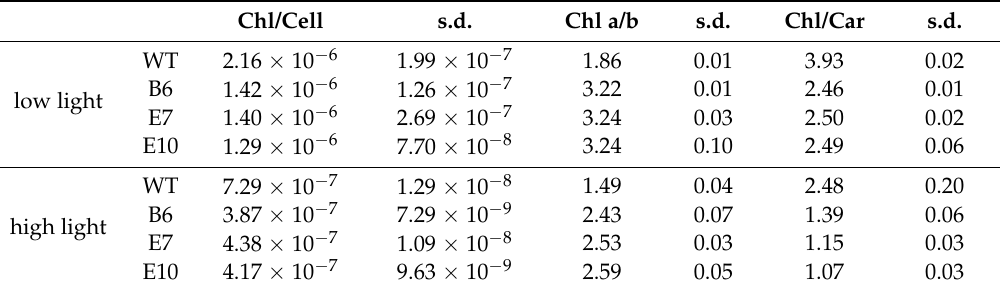
Table 1. Pigments analysis of transformed lines compared to WT. Chlorophyll content per cell, Chl a/b ratio, and Chl/Car ratio are reported with standard deviation ( n =